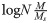
Evaluating the effect of sample size on prediction accuracy in simulation.Traits were simulated using SNPs of chromosome 1, chromosome 1 and 2, chromosome 1 to 4 and the whole genome while keeping the same proportion of causal variants and heritability to mimic the situation of increasing sample size. In the figure, logNr = logNMMs, where N is the number of individuals, M is the total number of variants and Ms is the number of variants used in simulation. In total four settings were simulated for each effective sample size: h2 = 0.25, p = 0.001; h2 = 0.25, p = 0.01; h2 = 0.5, p = 0.001; h2 = 0.5, p = 0.01, where p represents the proportion of causal variants. Each dot represent the mean COR of 50 replicates in one simulation setting and error bar represents the standard error.